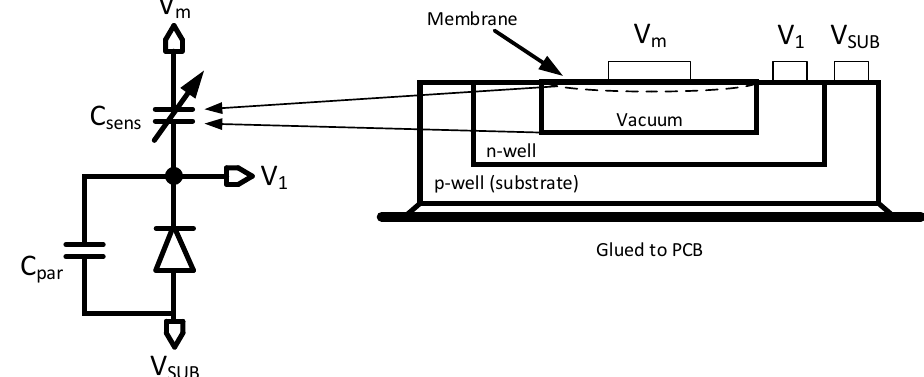
Figure 3. Schematic equivalent and physical MEMS sensor